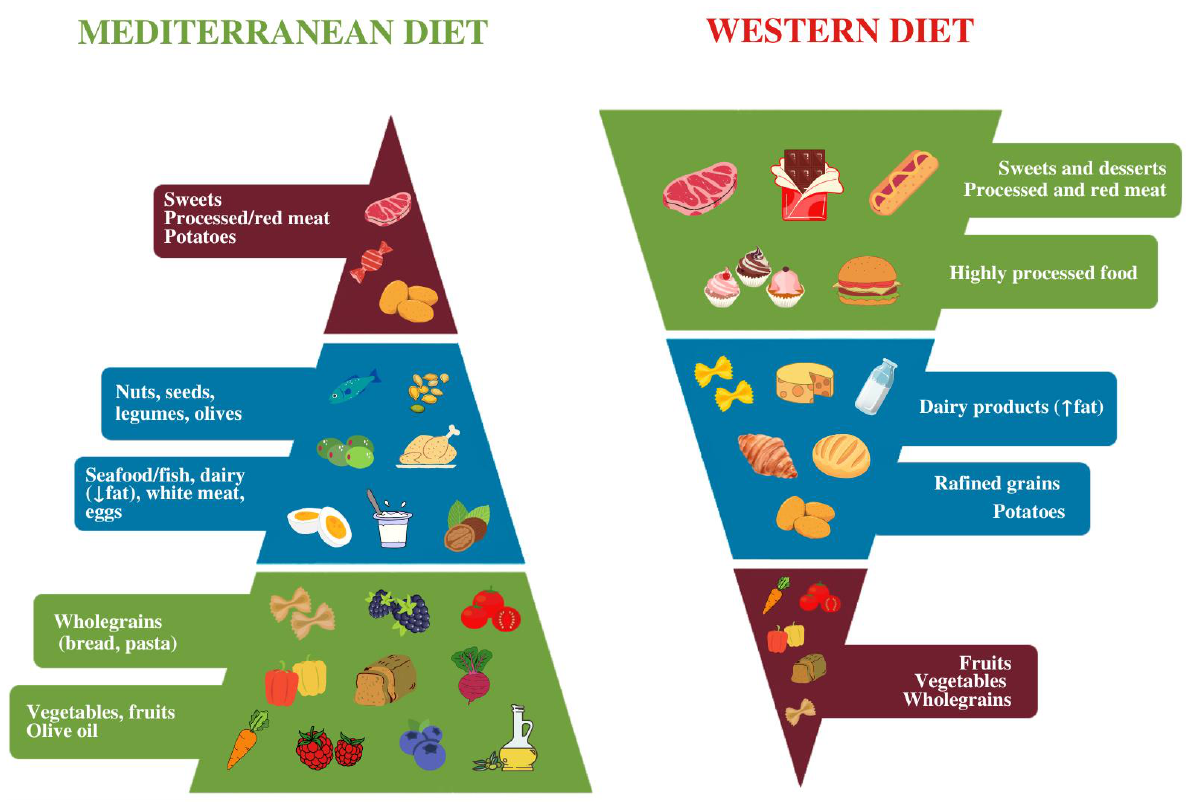
Figure 1. Characteristics of the Mediterranean and Western diet.